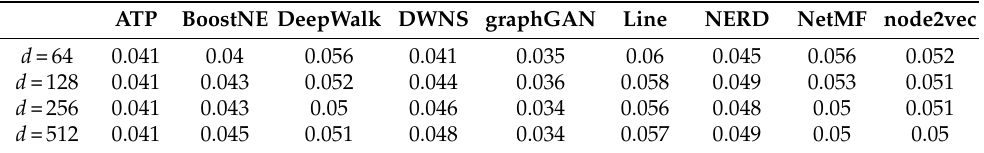
Table A5. Precision values of all embedding methods with the Wikipedia dataset and different values of d